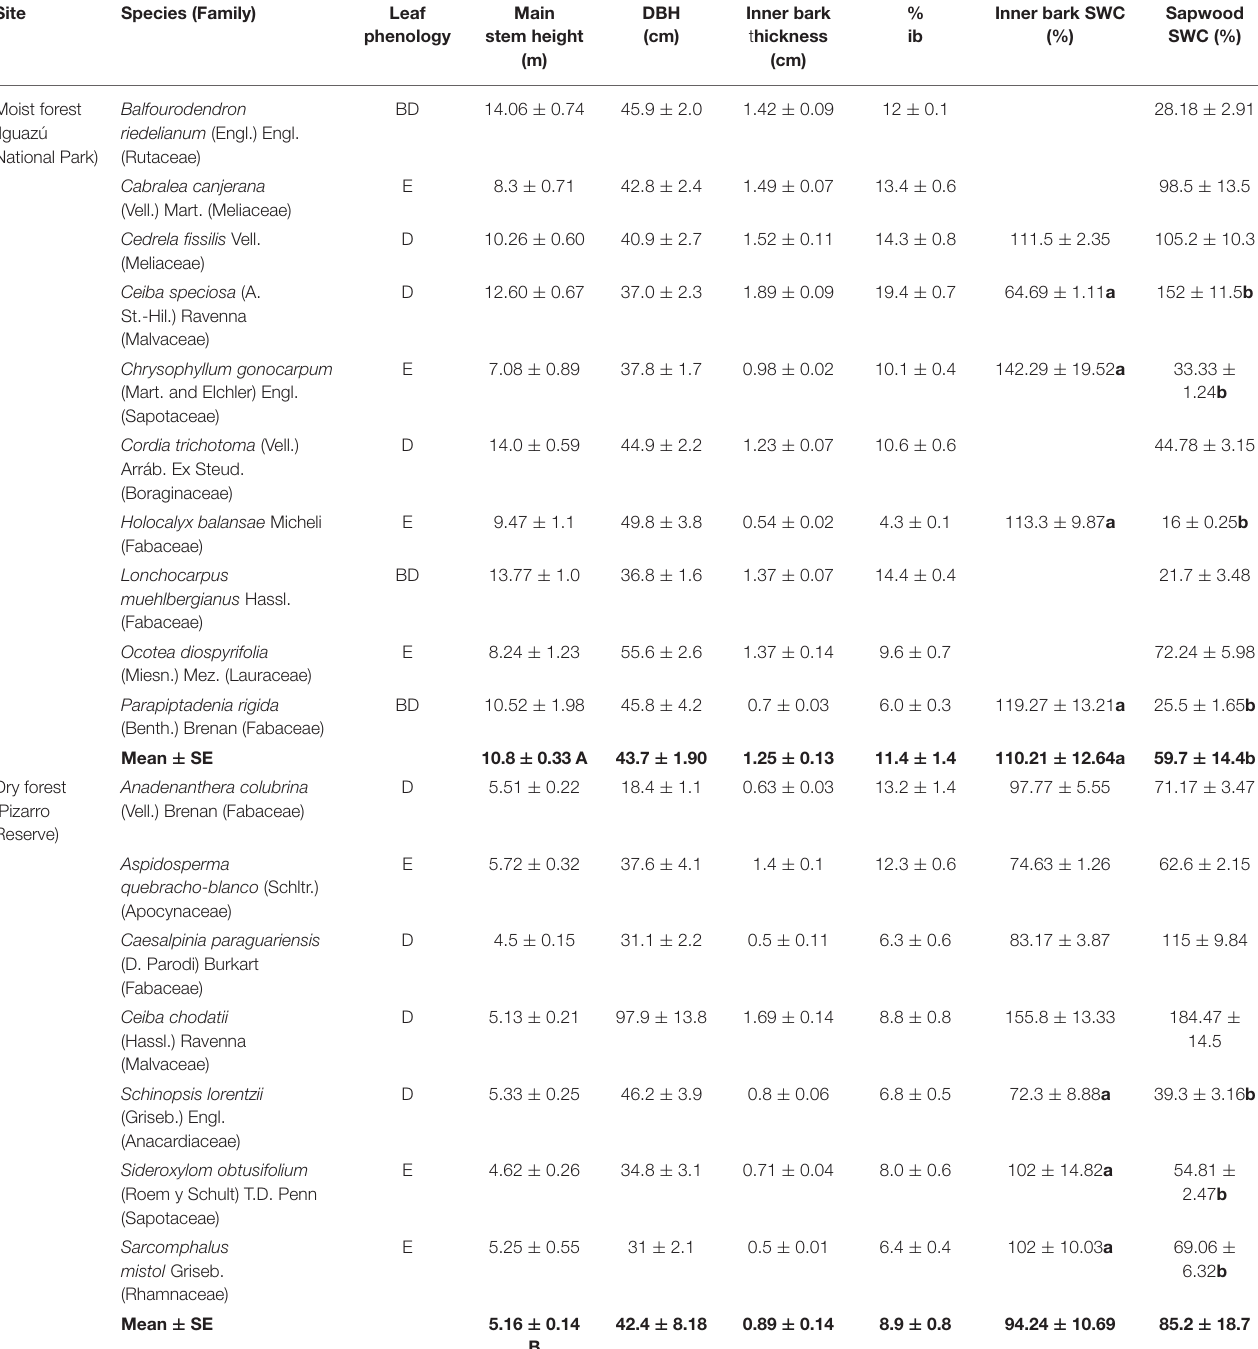
TABLE 1 | Leaf phenology (D, deciduous; BD, brevideciduous; E, evergreen), main stem height, diameter at breast height (DBH), inner bark thickness, inner bark saturated water content (SWC) and sapwood SWC of the studied tree species from moist (Iguazú National Park) and dry forest (Pizarro Reserve) in the extremes of a precipitation gradient in northern Argentina.